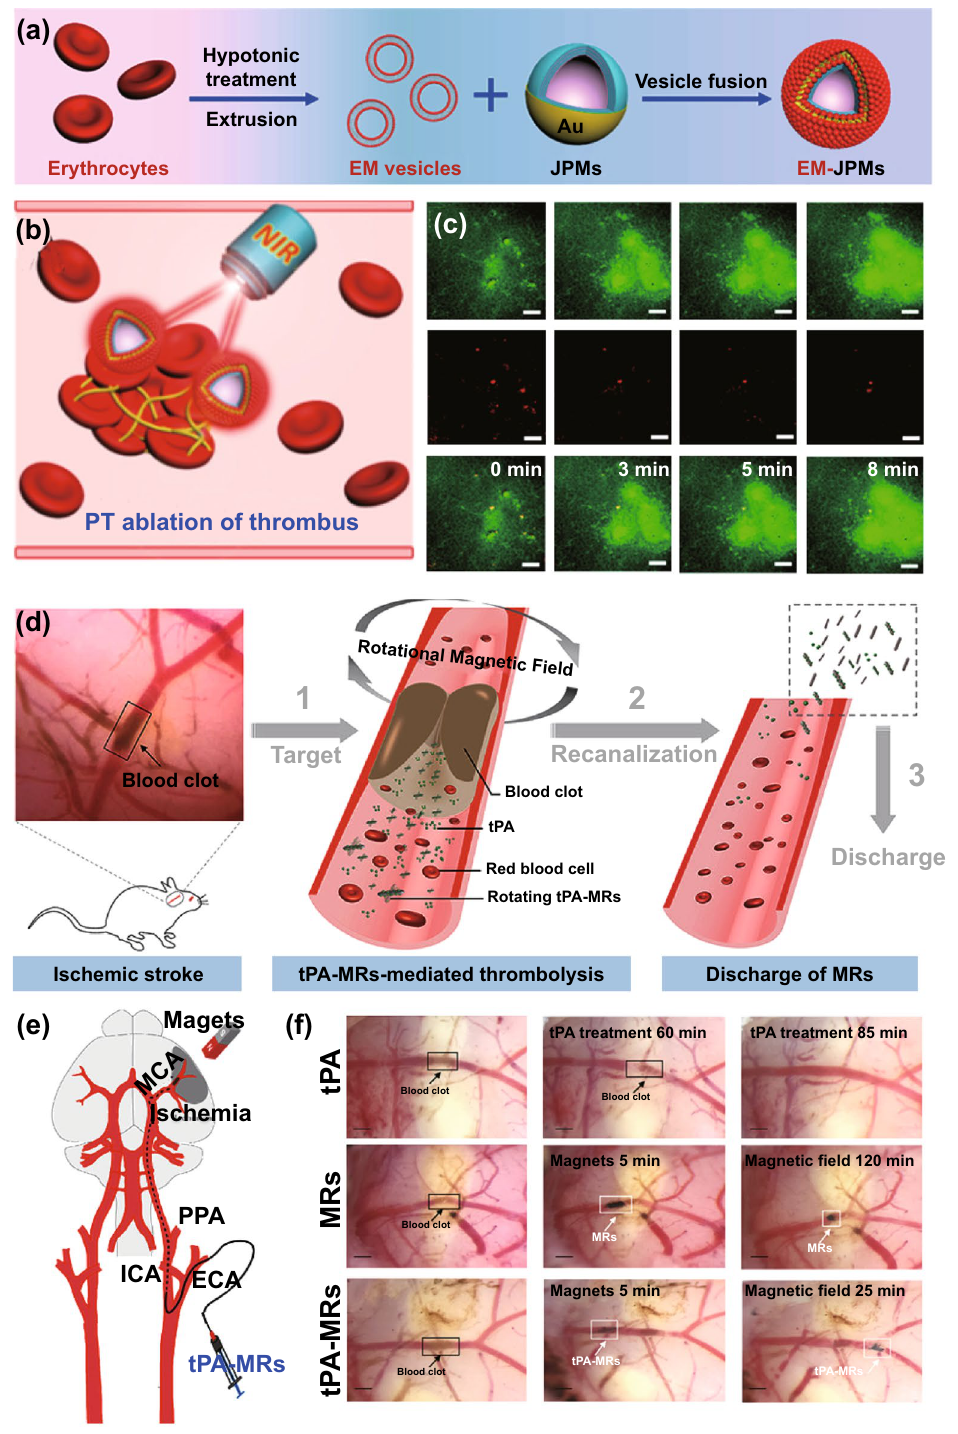
Fig. 9 Schematic illustration of a EM-JPMs, and b the PT ablation of thrombus. c Time lapsed TP-CLSM fluorescence images of thrombus after treated with PT ablation procedure [119]. Copyright 2018 Creative commons. Schematic illustration of d the magnetic field responsive thrombolysis strategy, and e magnetic guidance tPA-MRs administration of through ICA to MCA. f The optimal cutting temperature compound (OCT) images of thrombolysis after treated with tPA, MRs under a rotational magnetic field and tPA-MRs under a rotational magnetic